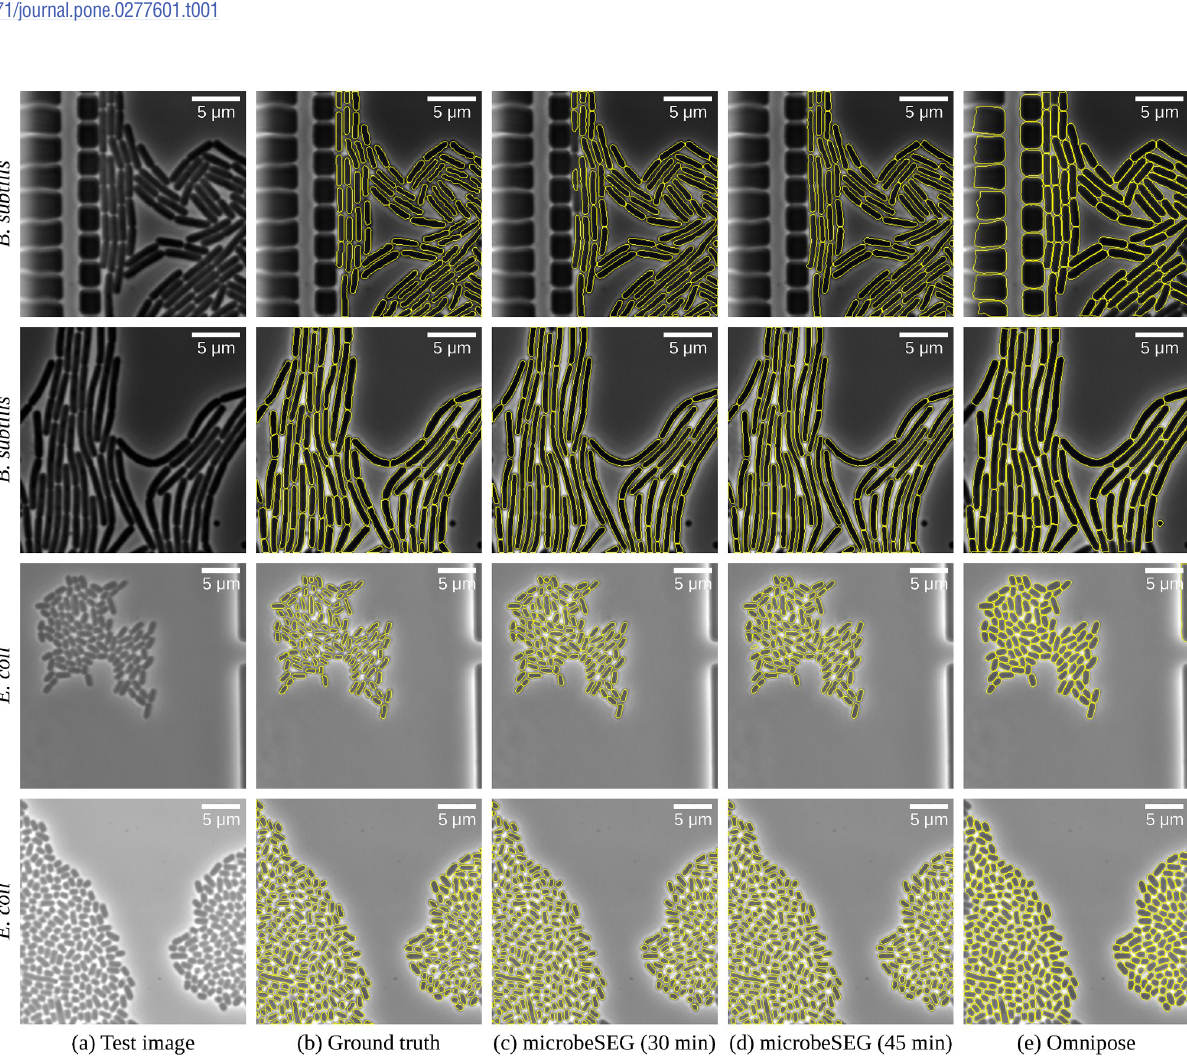
Fig 5. Exemplary images and segmentation overlays for B. subtilis and E.coli . Shown are the results of the median distance method microbeSEG models from Table 1. S2 Fig shows the raw network outputs of the microbeSEG model (d) and results for the boundary